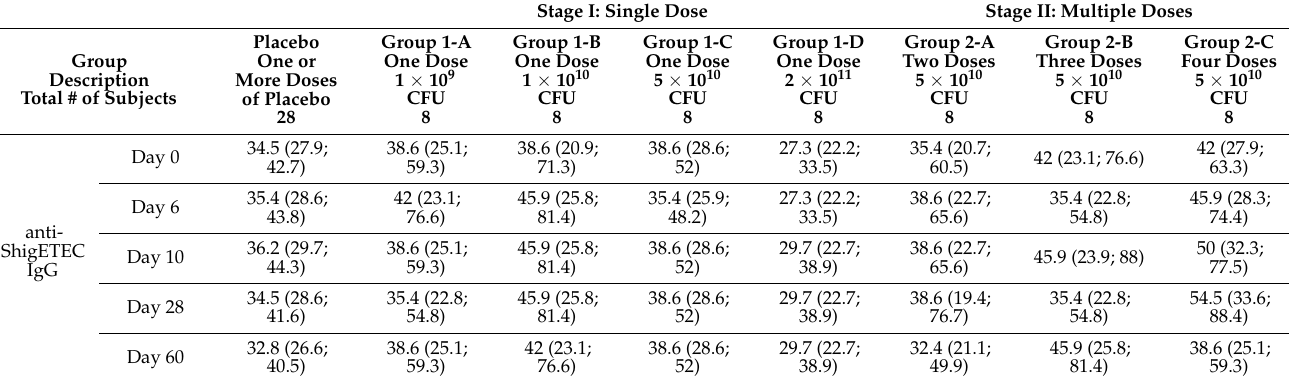
Table A2. Geometric mean titer (GMT) of IgG antibodies against ShigETEC, LTB and ST in serum. GMT and 95% confidence interval (in brackets) are given for indicated time points and antigens. Stage I: Single Dose Stage II: Multiple